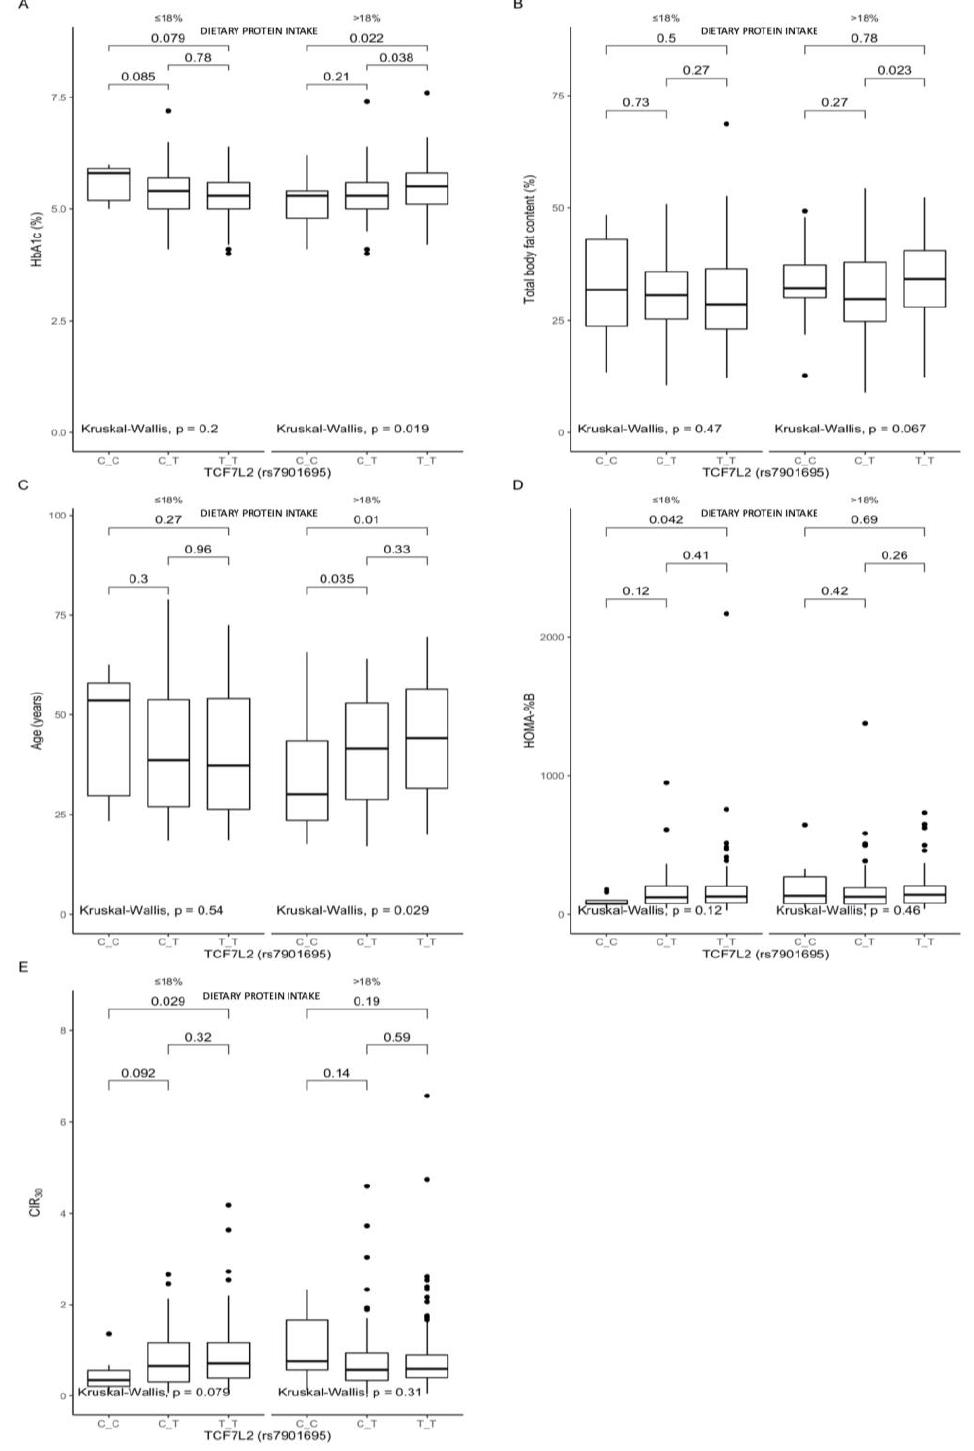
Figure 1. Association of the TCF7L2 rs7901695 genotypes with ( A ) HbA1c (%), ( B ) total body fat content (%), ( C ) age (years), ( D ) HOMA-B, and ( E ) CIR30 by dietary protein intake strata: ≤ 18% and >18% of total daily energy intake. The differences in median values of the selected responses and the interquartile ranges (IQRs) in different genotypic and dietary strata are presented. Kruskal–Wallis test p -values for the differences in median values within three strata are presented.